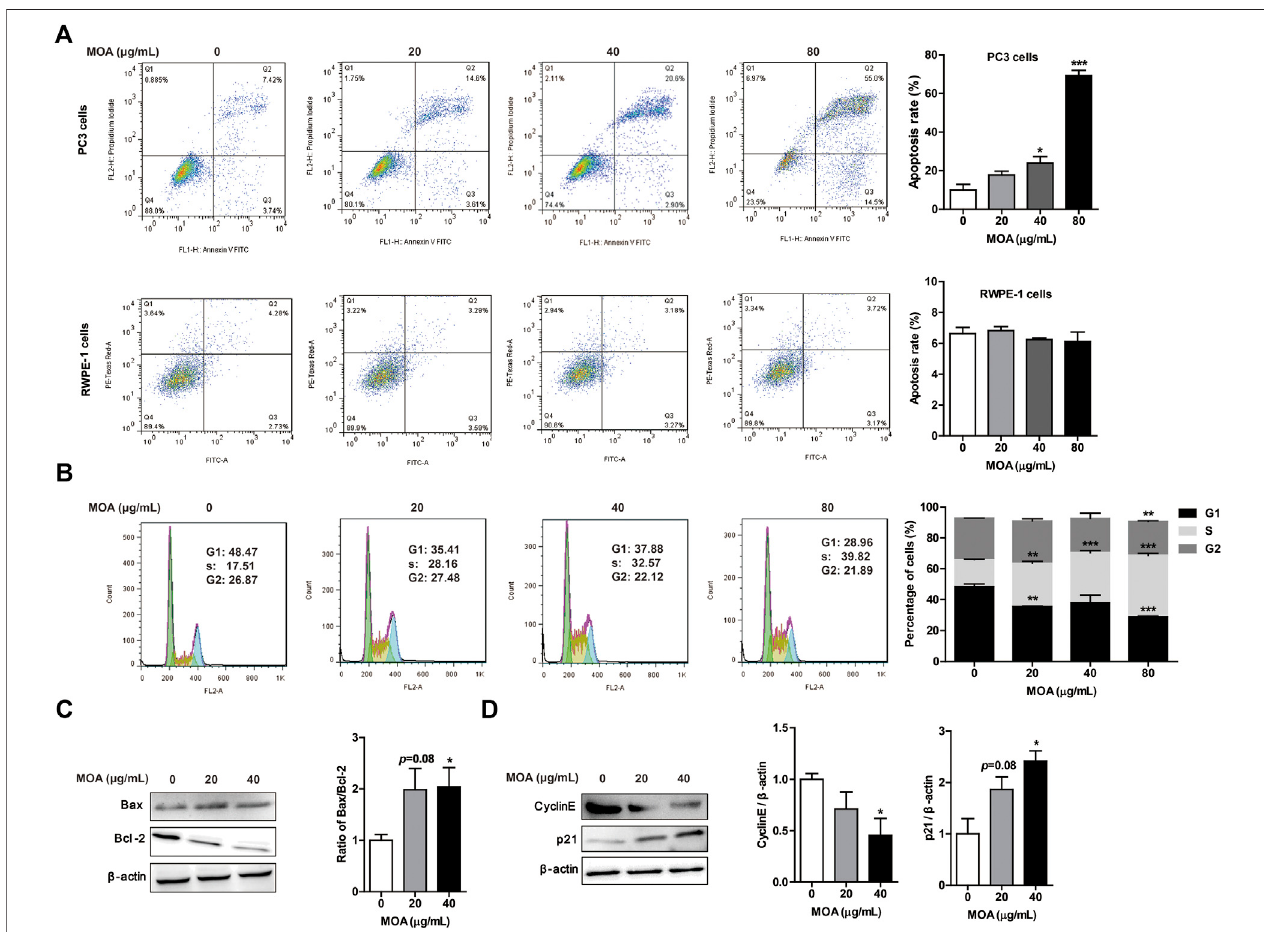
FIGURE2| TreatmentwithMOAinducedPC3cellapoptosisandcellcyclearrest.PC3andRWPE-1cellsweretreatedwithMOA(0,20,40,and80 μ g/ml)for48 h. The apoptosis of PC3 and RWPE-1 cells (A) , and cell cycle of PC3 cells (B) were determined by fl ow cytometry. The apoptosis proteins Bax and Bcl-2 (C) , and the cell cycleproteinscyclinEandp21 (D) ofPC3cellsweredetectedbywesternblotting,with β -actinasaloadingcontrol.Quanti fi cationofrelativeBax,Bcl-2,cyclinE,andp21 protein levels. Results are expressed as the mean ± SEM of three independent experiments. * p < 0.05, ** p < 0.01, and *** p < 0.001 vs. 0 μ g/ml.